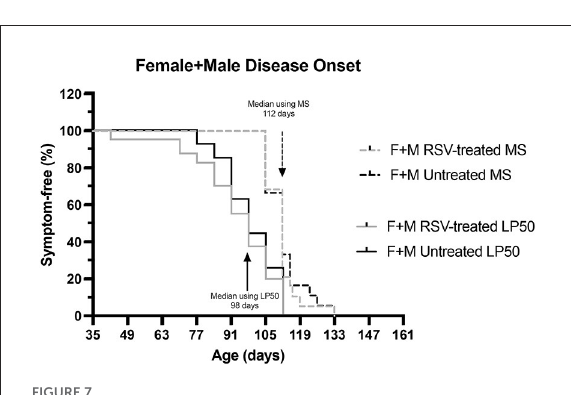
FIGURE7 Kaplan-Meier curves comparing disease onset for combined (Female + Male) RSV-treated vs. untreated ALS mice as determined by MS or by LP 50kHz. Disease onset was determined either as the time of the first recorded MS = 3 or as the time of 20% reduction in LP 50kHz value from baseline. The median time of disease onset was 112 days for both RSV-treated and untreated animals using MS and 98 days for both RSV-treated and untreated animals using LP 50kHz as the